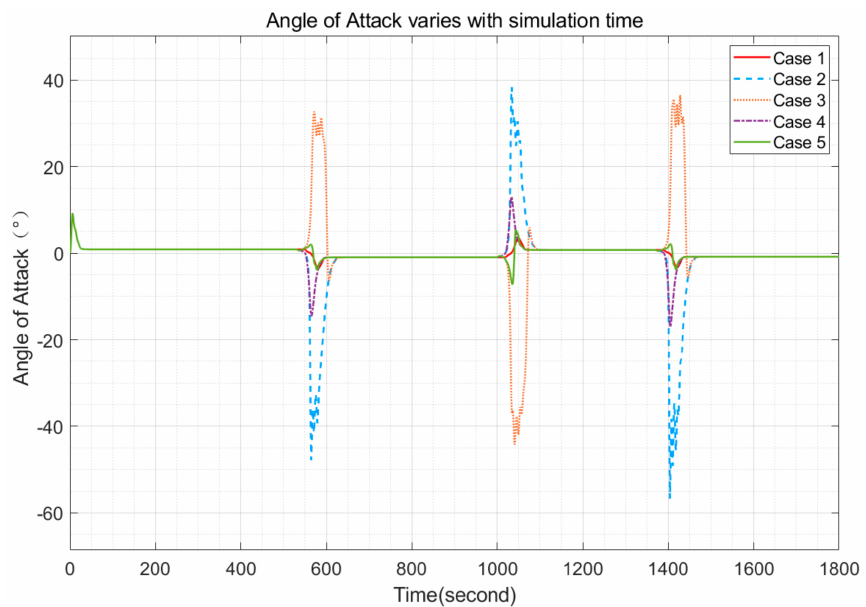
Figure 9. Angle of attack varies with simulation time.